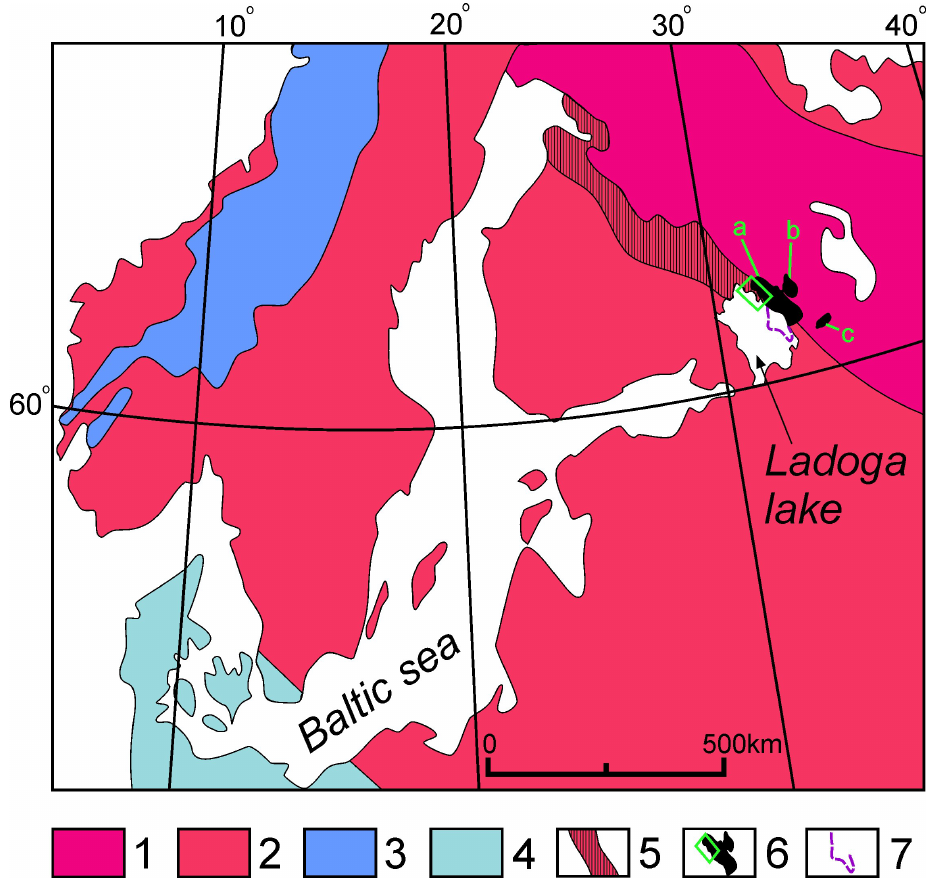
Figure 1. Schematic geological map of the location of the Salmi batholith, compiled by the author taking into account the material presented in [1,6,26]. 1, Arhean foundament; 2, area of the Svecofennian orogen; 3, area of the Kaledonian orogen; 4, rocks beyond the East European craton; 5, Raahe-Ladoga zone; 6, Anortosite-rapakivi granite-bearing complex (ARG) with the area of interest (green frame); and 7, boundaries of the ARG complex rocks under the Ladoga lake. The green letters indicate a—the Salmi batolith, b—the Ulaleg massif, and c—the Lodeinopolskiy massif. The age of the batholith, estimated by the U-Pb system in zircons, is 1547–1530 Ma [9,27]. Biotite-amphibole granite occupies the largest area on the modern surface of the